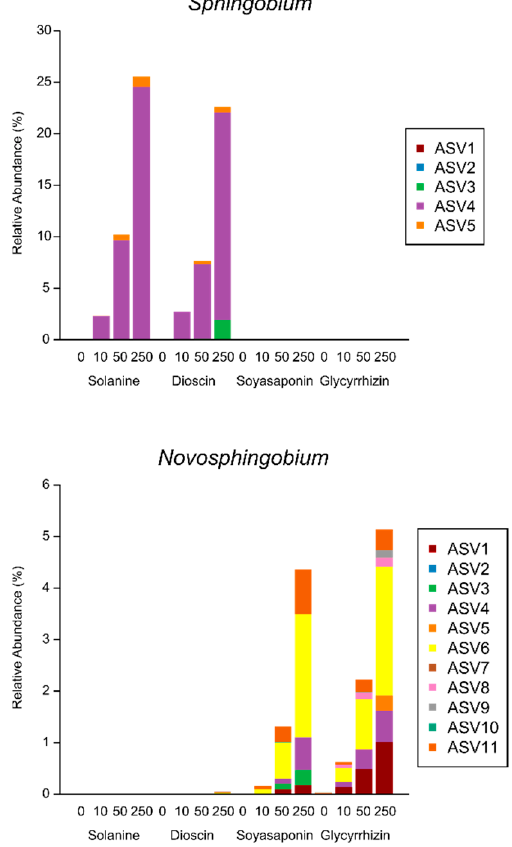
Figure 7. The mean relative abundances of amplicon sequence variants (ASVs) found in the genera Novosphingobium and Sphingobium of Sphingomonadaceae in soils treated with 10, 50, and 250 nmol (low, middle, and high concentrations) of saponins g soil − 1 ( n = 4).